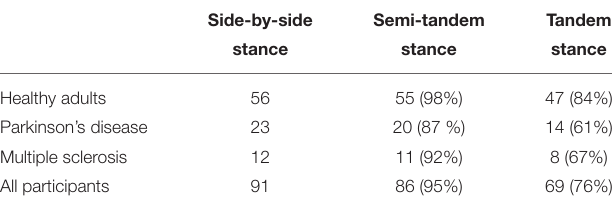
TABLE 2 | Number of participants that were able to perform the stance tasks. Side-by-side Semi-tandem Tandem